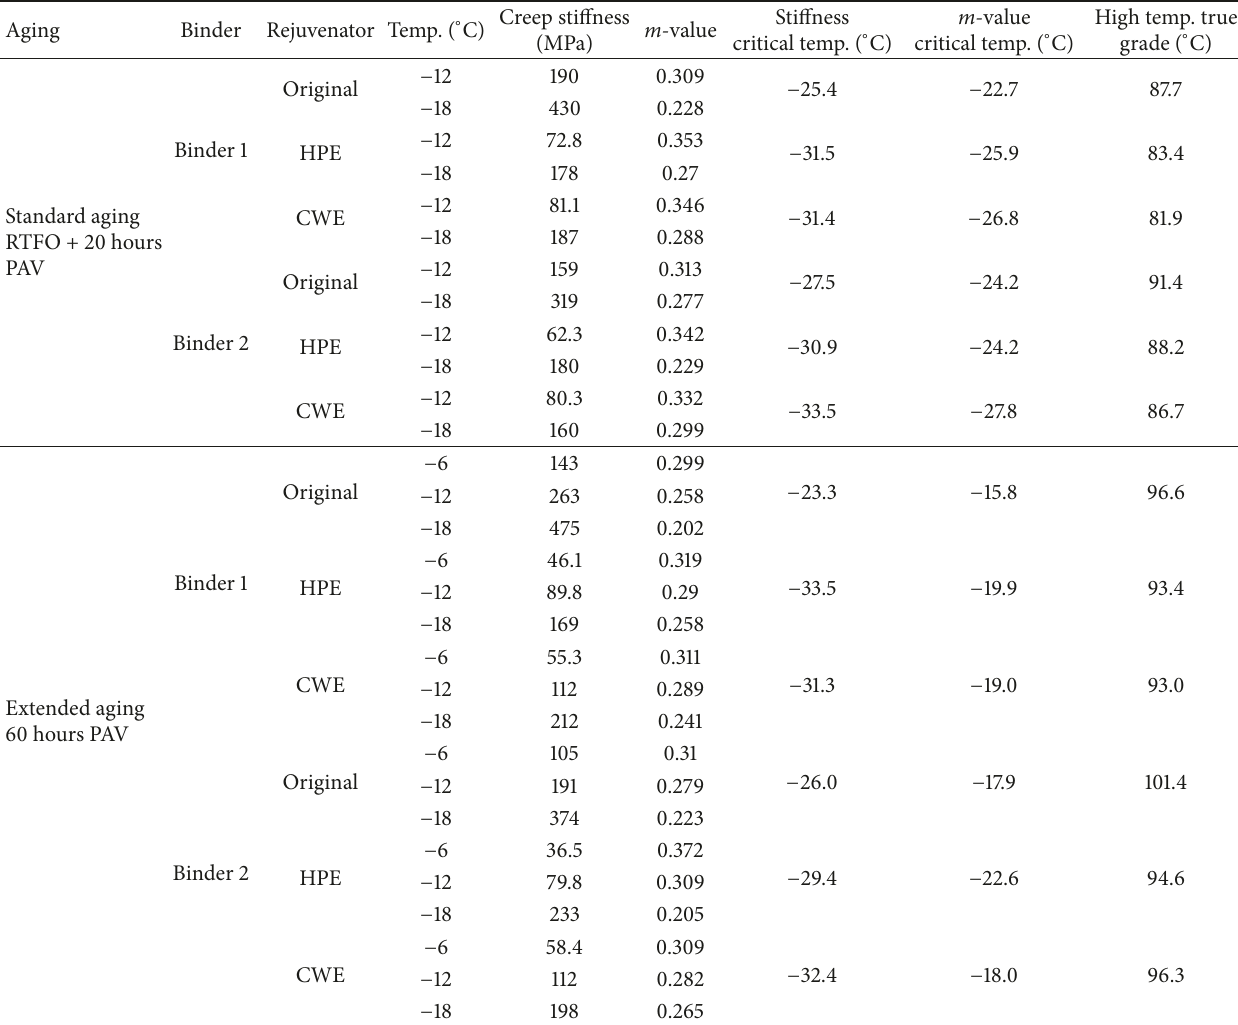
Table 4: BBR test